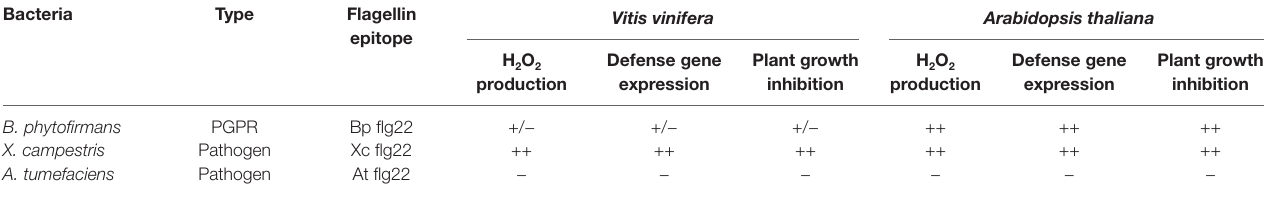
TABLE 1 | Intensity of the immune responses, in Vitis vinifera and Arabidopsis thaliana , following treatment with 1 µM of flagellin-derived flg22 epitopes derived from beneficial or pathogenic bacteria. ++, highly induced; +, induced; +/−, weakly induced; −, not induced; PGPR, plant growth-promoting bacteria. Results from Trdá et al., 2014.